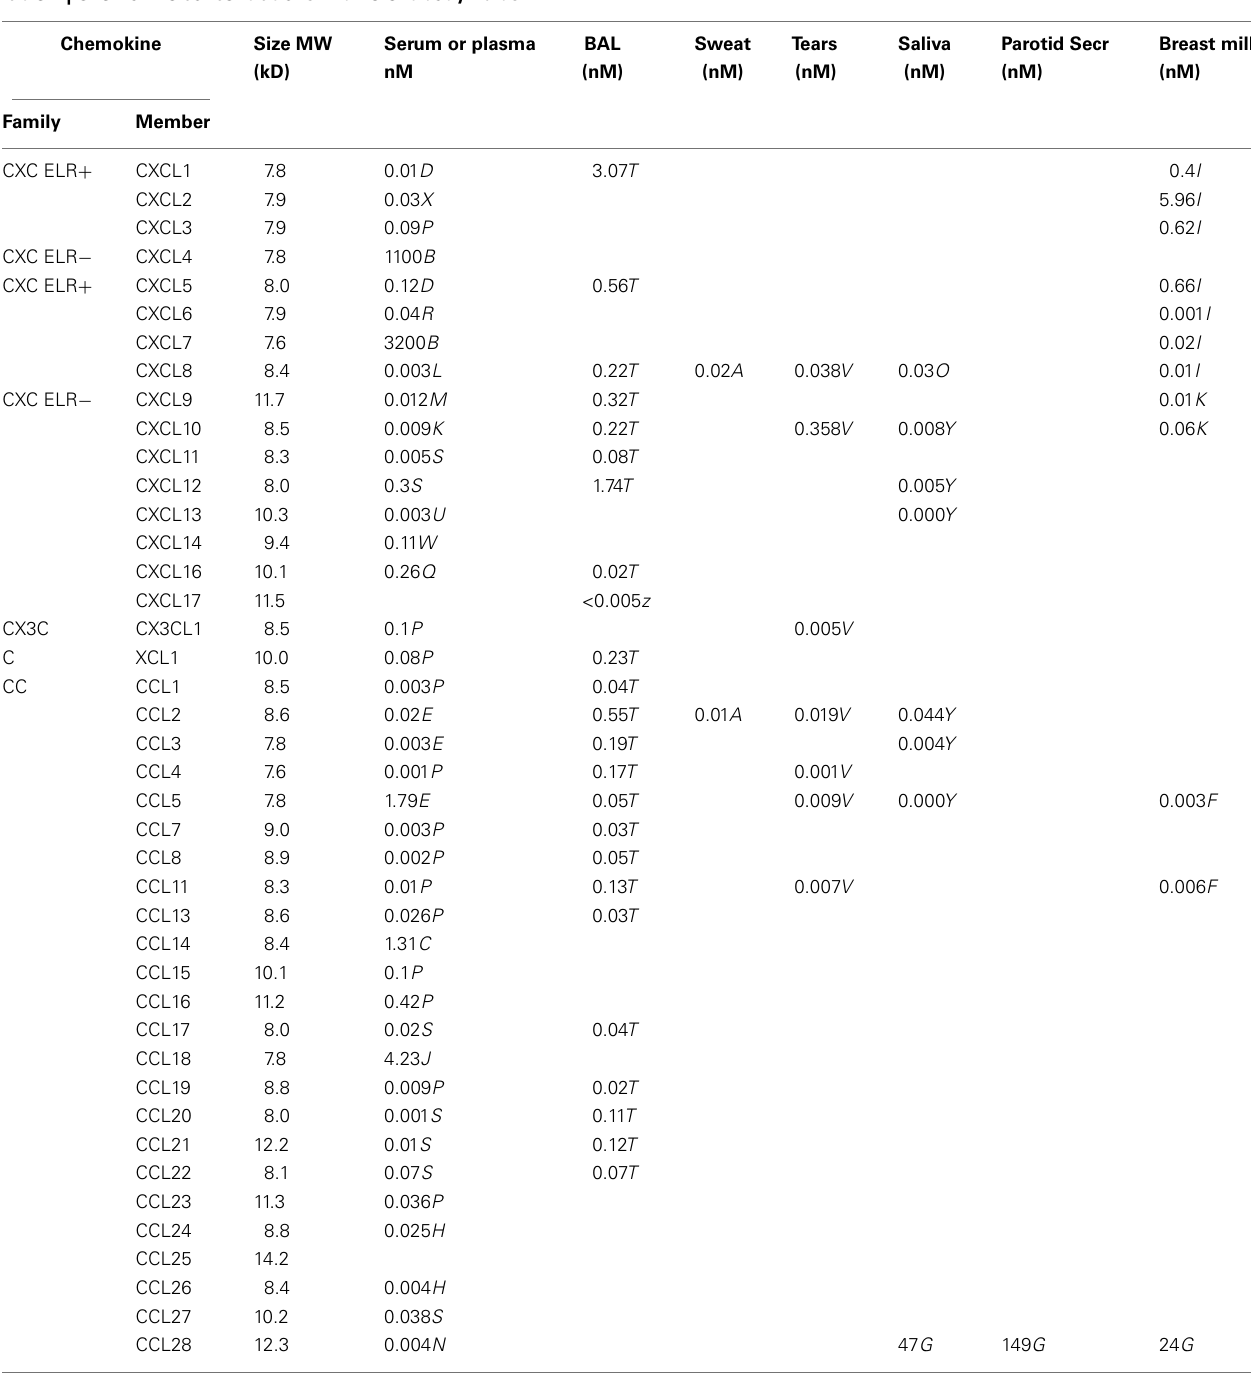
Table 2 | Chemokine concentrations in different body